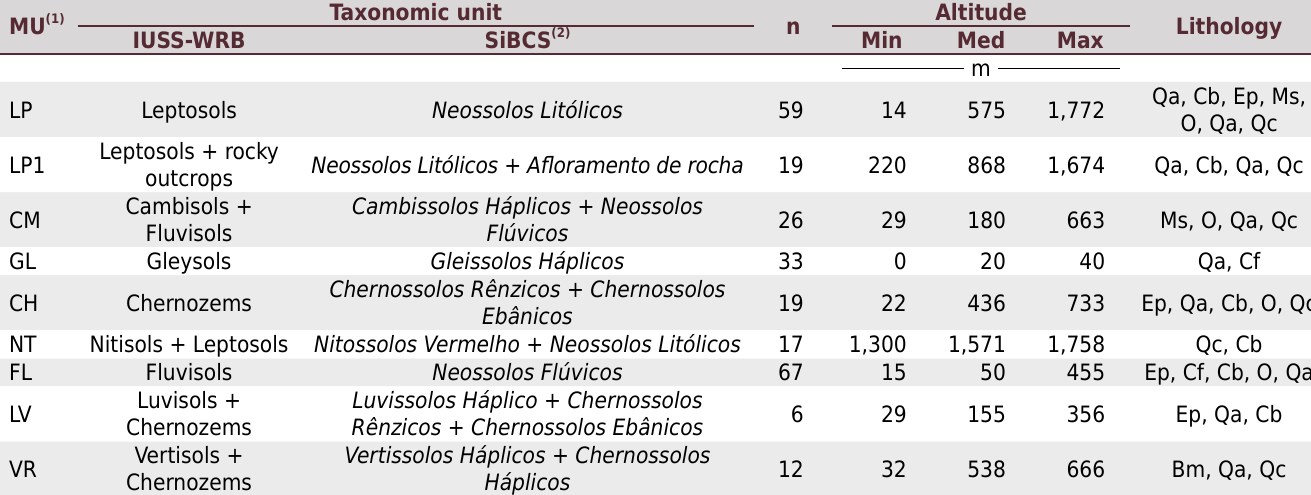
(1) Map units. (2) Brazilian Soil Classification System. n = number of soil data; Bm = basalts; Cb = volcanic sedimentary rocks; Cf = flysch and, sandstone, and limestone; Ep = marlstone and limestone; Ms = sandstone and marl; O = gypsum and limestone; Qa = alluvial deposits and detrital particles; Qc = hard